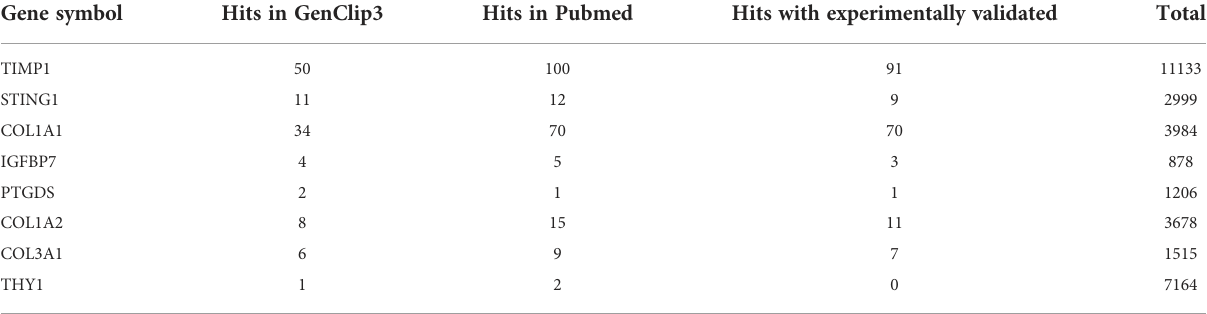
TABLE 1 The searching results of related literature about the top 20 hub genes and